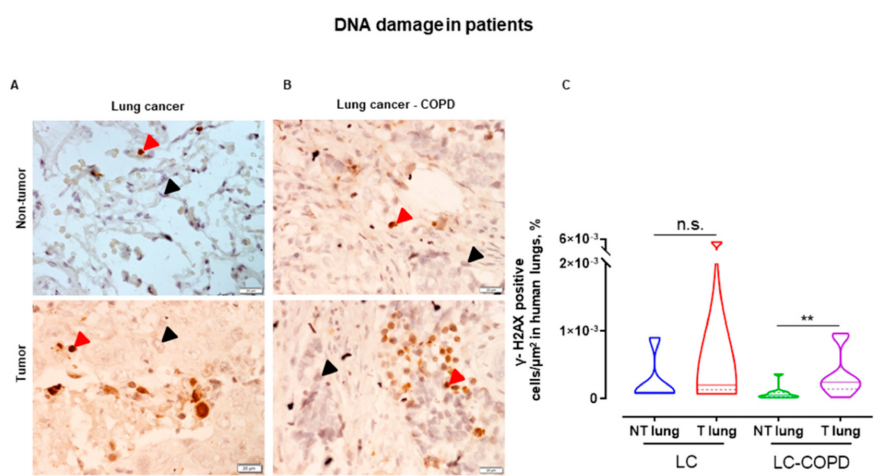
Figure 1. ( A , B ) Representative immunohistochemical staining sections of γ -H2AX in non-tumor and tumor lung specimens of LC and LC-COPD patients. Red arrows point towards γ -H2AX cells, which were positively stained in brown, and black arrows point towards γ -H2AX cells that remained stained in blue (hematoxylin counterstaining). ( C ) Violin plots with median (continuous line) and interquartile ranges (discontinuous lines) of the number of γ -H2AX positively stained cells in the total measured area. Statistical significance: n.s., no significance, ** p < 0.01 between non-tumor and tumor samples in LC-COPD patients. Definition of abbreviations: PARP, poly (ADP-ribose) polymerase; LC, lung cancer; COPD, chronic obstructive pulmonary disease.